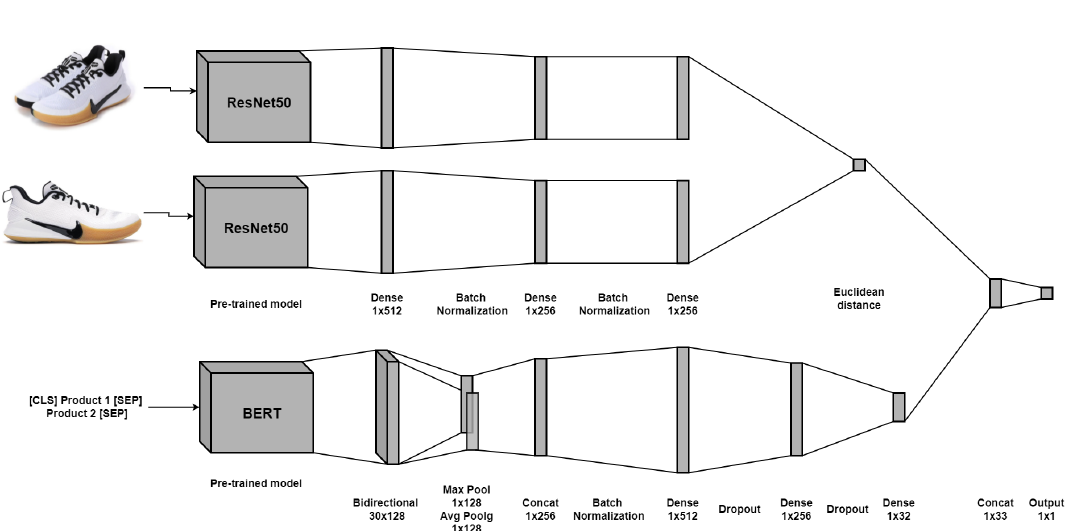
Figure 9. BERTSiamese